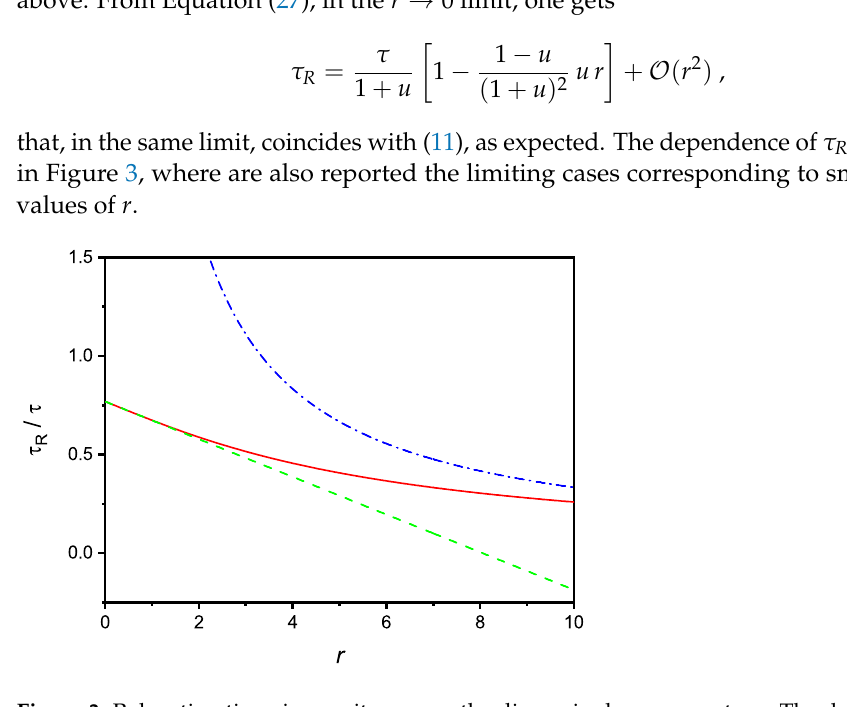
Figure 3. Relaxation time, in τ units, versus the dimensionless parameter r . The dashed and dash- dotted lines are the limiting cases of large and small r , respectively. The figure is drawn for u =